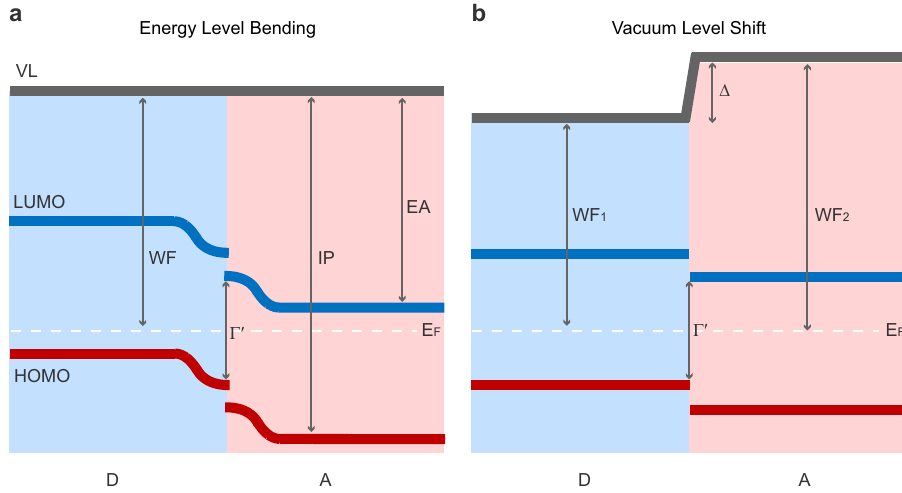
Fig. 1 Schematic energy level diagram of donor (D) – acceptor (A) interfaces. a Energy level bending (ELB) scenario and b vacuum level (VL) shift scenario. The energy difference between the VL and the highest occupied molecular orbitals (HOMO) level is denoted as ionization potential (IP). The energy difference between VL and the lowest unoccupied molecular orbitals (LUMO) level is denoted as electron af fi nity (EA). The photovoltaic gap ( Γ ′ ) could be enhanced either by bending of energy levels at the interface (ELB scenario) or by interface dipole ( Δ ) induced shifting of the vacuum level (VL shift scenario). In the VL shift scenario, work function (WF) of each phase is denoted as WF 1 and WF 2 , respectively. Fermi level (white dashed line) is denoted as E F